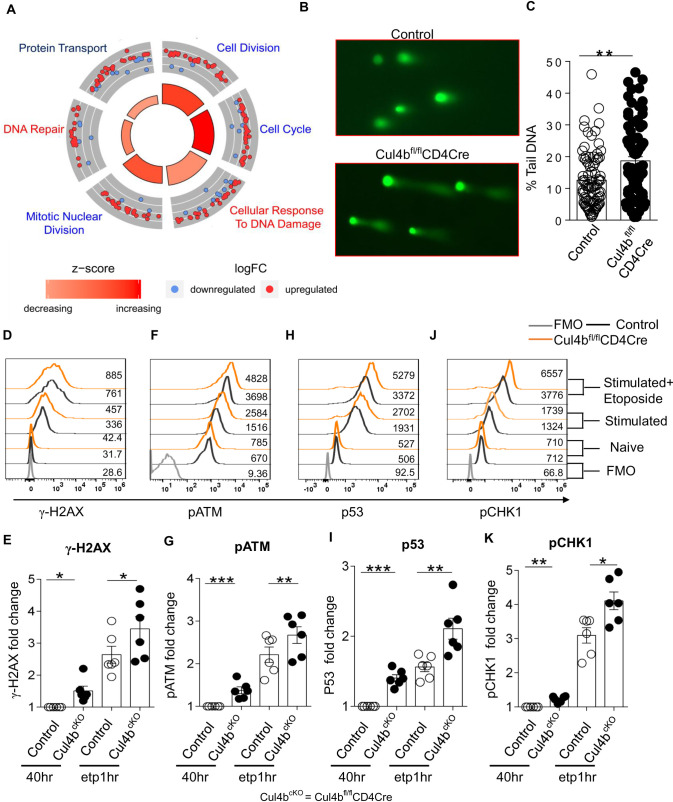
Cul4b regulates DNA damage response of activated CD4+ T cells.(A) Cul4b-deleted (Cul4bfl/fl-CD4Cre) and control (Cul4bfl/fl) CD4+ T cells were cultured for 3 days and then rested in IL-2 for 2 days. After resting, these cells were restimulated for 4 h with anti-CD3/CD28 mAbs (5 μg/ml). Proteins were quantified by iBAQ intensities values and were compared between control and Cul4b-deleted CD4+ T cells to generate fold changes. Ontological analysis of the 517 proteins, which showed significant changes in relative abundance between Cul4bfl/fl-CD4Cre and control (Cul4bfl/fl) CD4+ T cells, is represented. The circular plot depicts the enriched functional networks of proteins. The outer circle is a scatter plot for each biological term of the logFC of the enriched proteins. Within each network, a protein is depicted as a dot, red for up-regulated and blue for down-regulated. The size of the inner trapezoids corresponds to the adjusted P value, and the color indicates the z-score as calculated by GOplot algorithm. (B) Detection of DNA damage in ETP-treated activated T cells via comet assay. CD4+ T cells were stimulated with anti-CD3/CD28 mAb; on day 2, cells were treated with ETP (10 μM) for 1 h. (C) The percent tail DNA was calculated using OpenComet software (**P < 0.01, by Student t test). (D–K) The expression of γ-H2AX, pATM, P53, and pCHK1 was analyzed by flow cytometry. The CD4+ T cells were stimulated with anti-CD3/CD28 mAb for 40 h; after 40 h, cells were either treated with ETP (10 μM) for 1 h or left as such. The expression in unstimulated control and Cul4bfl/fl-CD4Cre, 40 h stimulated control and Cul4bfl/fl-CD4Cre, and ETP-treated control and Cul4bfl/fl-CD4Cre CD4+ T cells is shown. The FMO controls were used to determine positivity. The fold change in fluorescence was calculated by dividing the fluorescence intensity with that of control (40 h stimulated). Bar graph shows the fold change in median fluorescence intensity, n = 6. (*P < 0.05, **P < 0.01, by Student t test). For numerical raw data, please see S6 Data. For supporting dataset, please see S1 Table. Cul4b, Cullin-4b; ETP, etoposide; FMO, fluorescence minus one; iBAQ, intensity-based absolute quantification; IL-2, interleukin 2; mAbs, monoclonal antibodies.